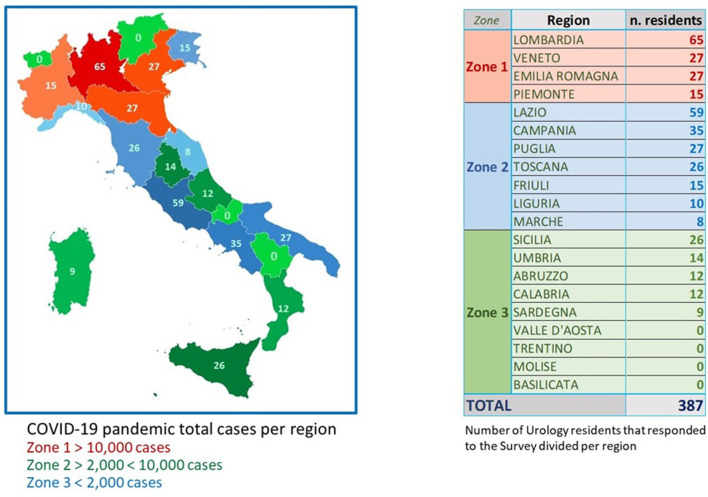
Topographical distribution of urology residents who completed our survey in relation to the three geographical zones defined on the basis of COVID-19 cases.